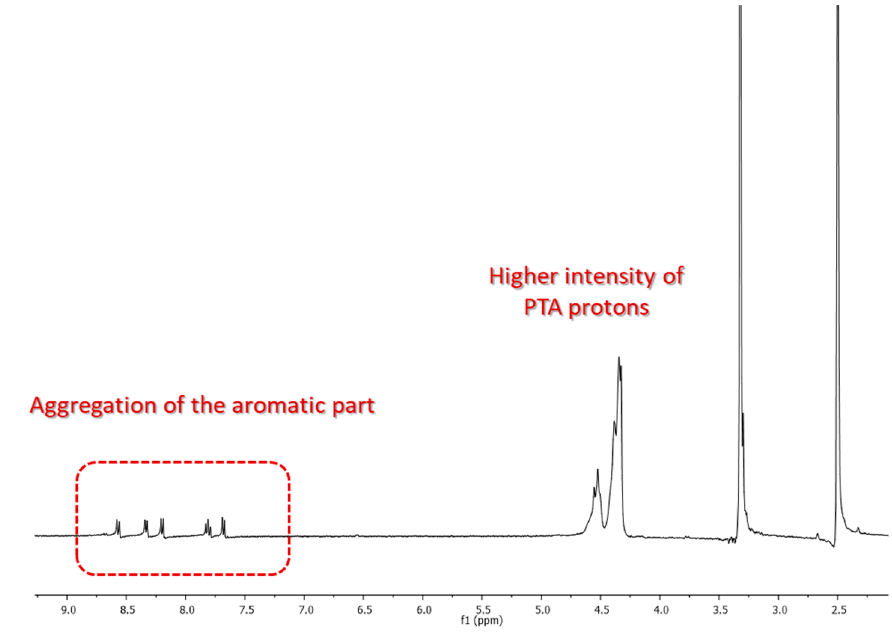
Figure 2. 1 H-NMR spectrum of freshly dissolved solution of 1 in DMSO- d 6 .